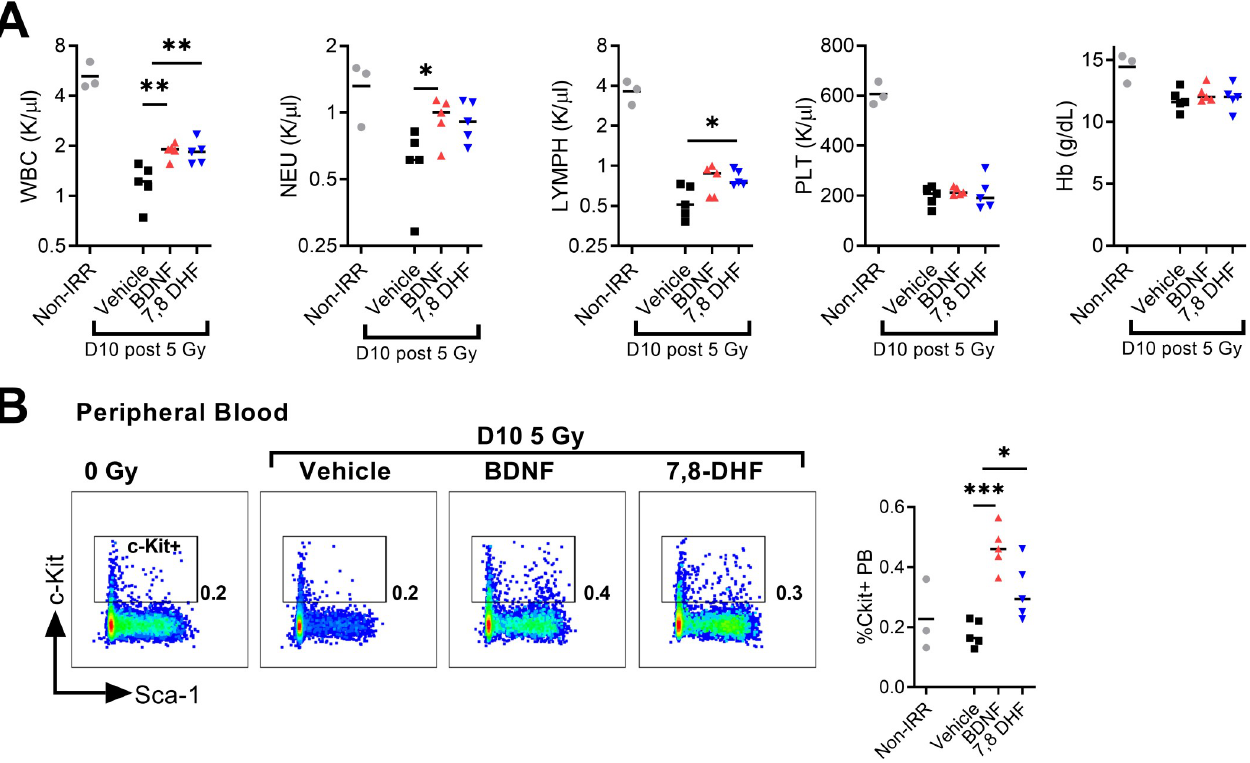
Fig 3. Pharmacologic activation of BDNF-TrkB signaling promotes reconstitution of peripheral blood neutrophils and lymphocytes. (A) Day 10 CBC analysis of total WBCs, neutrophils (NEU), lymphocytes (LYMPH), platelets (PLT), and hemoglobin (Hb). (B) Day 10 peripheral blood analysis of circulating Lin- c-kit+ cells. (n = 5 mice per group). � P < .05, �� P < .01, ��� P < .001.